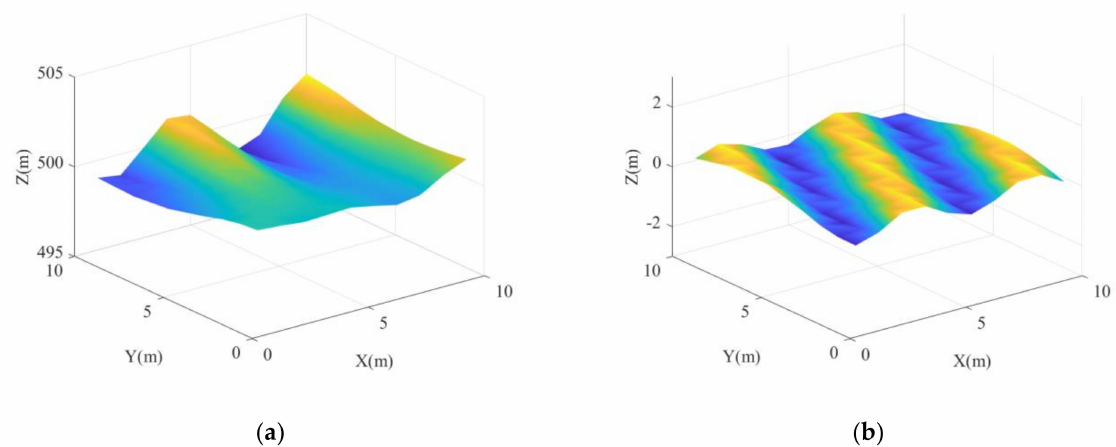
Figure 16. ( a ) Reconstructed 3D imaging result by using the Doppler frequency shift method; ( b ) The difference between the reconstructed and the ideal 3D imaging